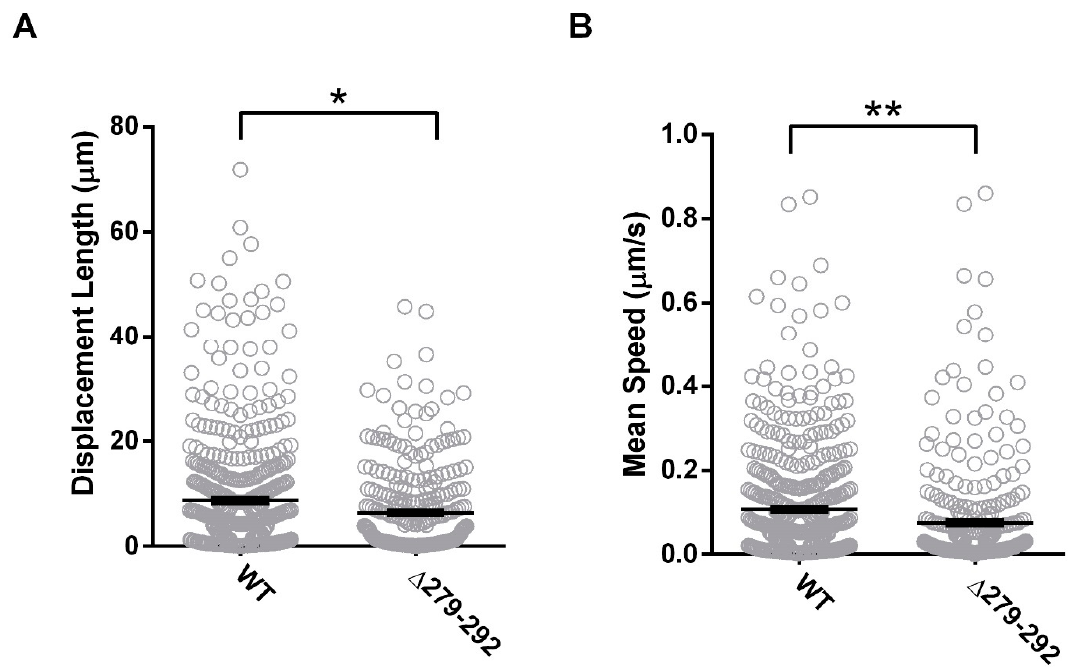
Figure 3. Tubulin interaction mediates the spatiotemporal delivery of Cx36 vesicles within the submembrane. In Cx36-EGFP and tubulin-mCherry co-transfected cells, submembrane vesicular transport was monitored using Total Internal Reflection Fluorescence (TIRF) microscopy. Mutant expression reduced trafficking as determined by the reduction in ( A ) displacement ( µ m) and ( B ) mean speed ( µ m / s). Data are mean ± SEM; sample sizes ( n ) of WT Cx36 were n = 475 and n = 304 for Cx36 ∆ 279–292 vesicles. * p < 0.05, ** p < 0.001, Kruskal–Wallis